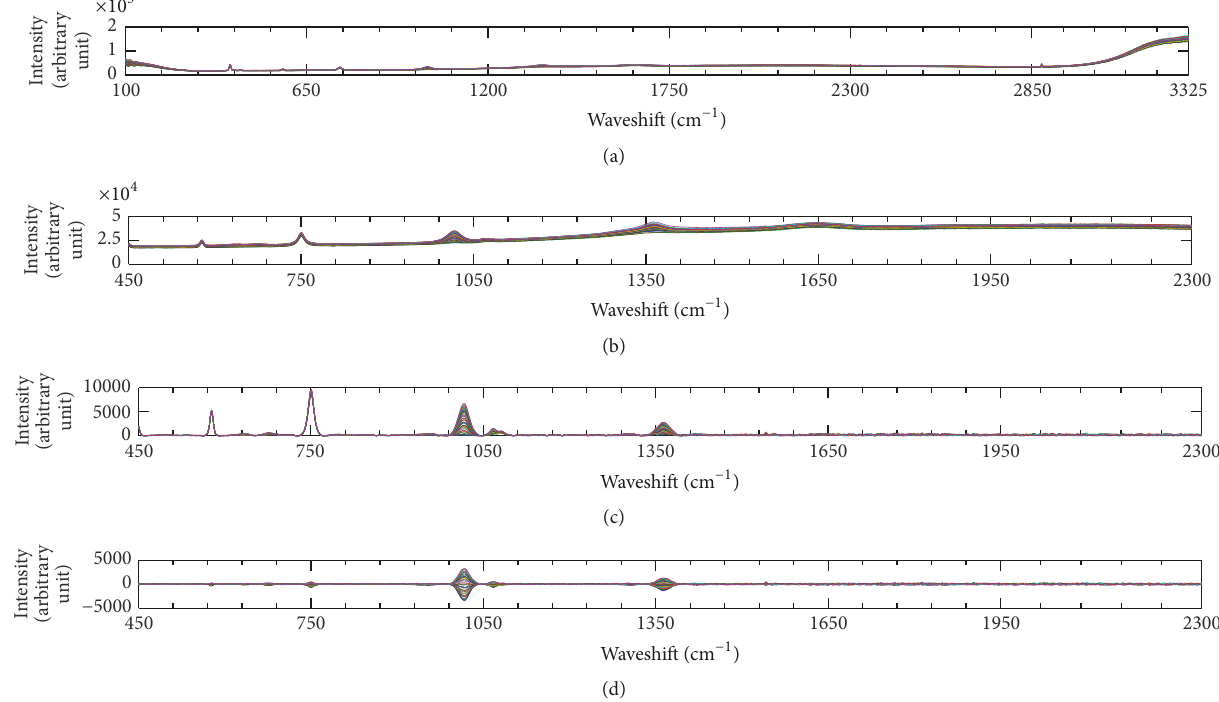
Figure 2: Preprocessing steps of the calibration and validation Raman spectra of bicarbonate. (a) Raw spectra for the range of 100–3325 cm −1 . (b) Spectra cropped to cover the range of 450–2300 cm −1 . (c) Spectra baseline corrected using the Whittaker filter (lambda = 100; 𝑃 = 0.001 ). (d) Mean-centered spectra for PLS-R model